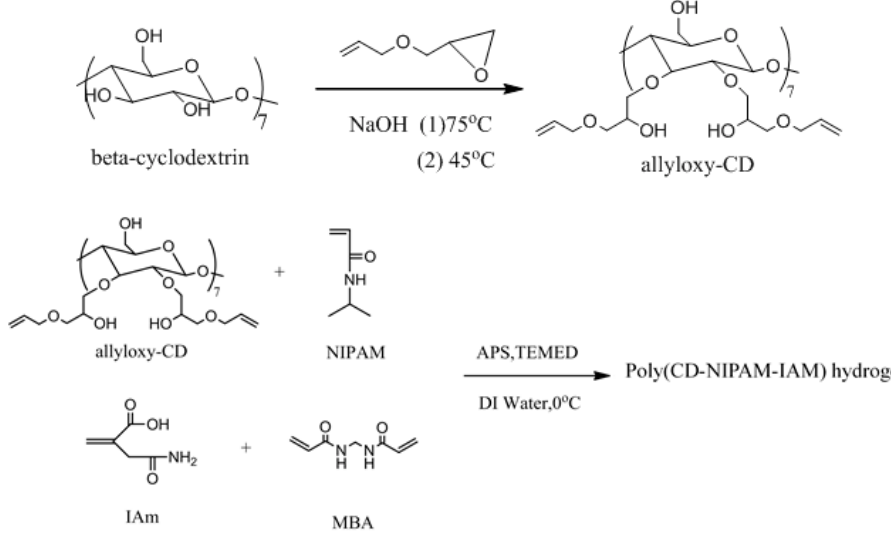
Figure 1. Synthesis of heptakis [2,3-di- O -(3-allyloxy-2-hydroxypropyl)]- β -CD (allyloxy- β -CD) and poly(CD-NIPAM-IAM).